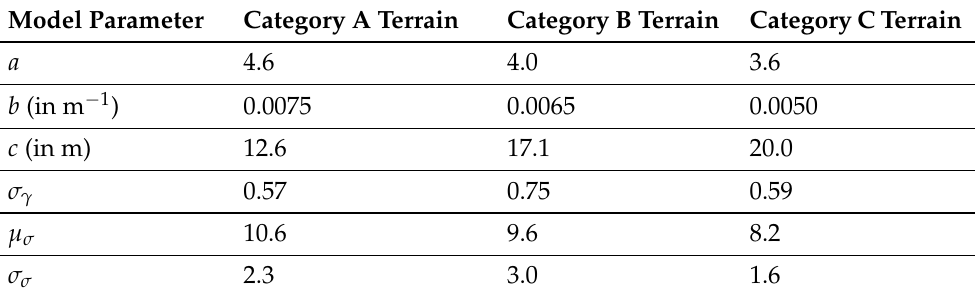
Table 7. Erceg-SUI model